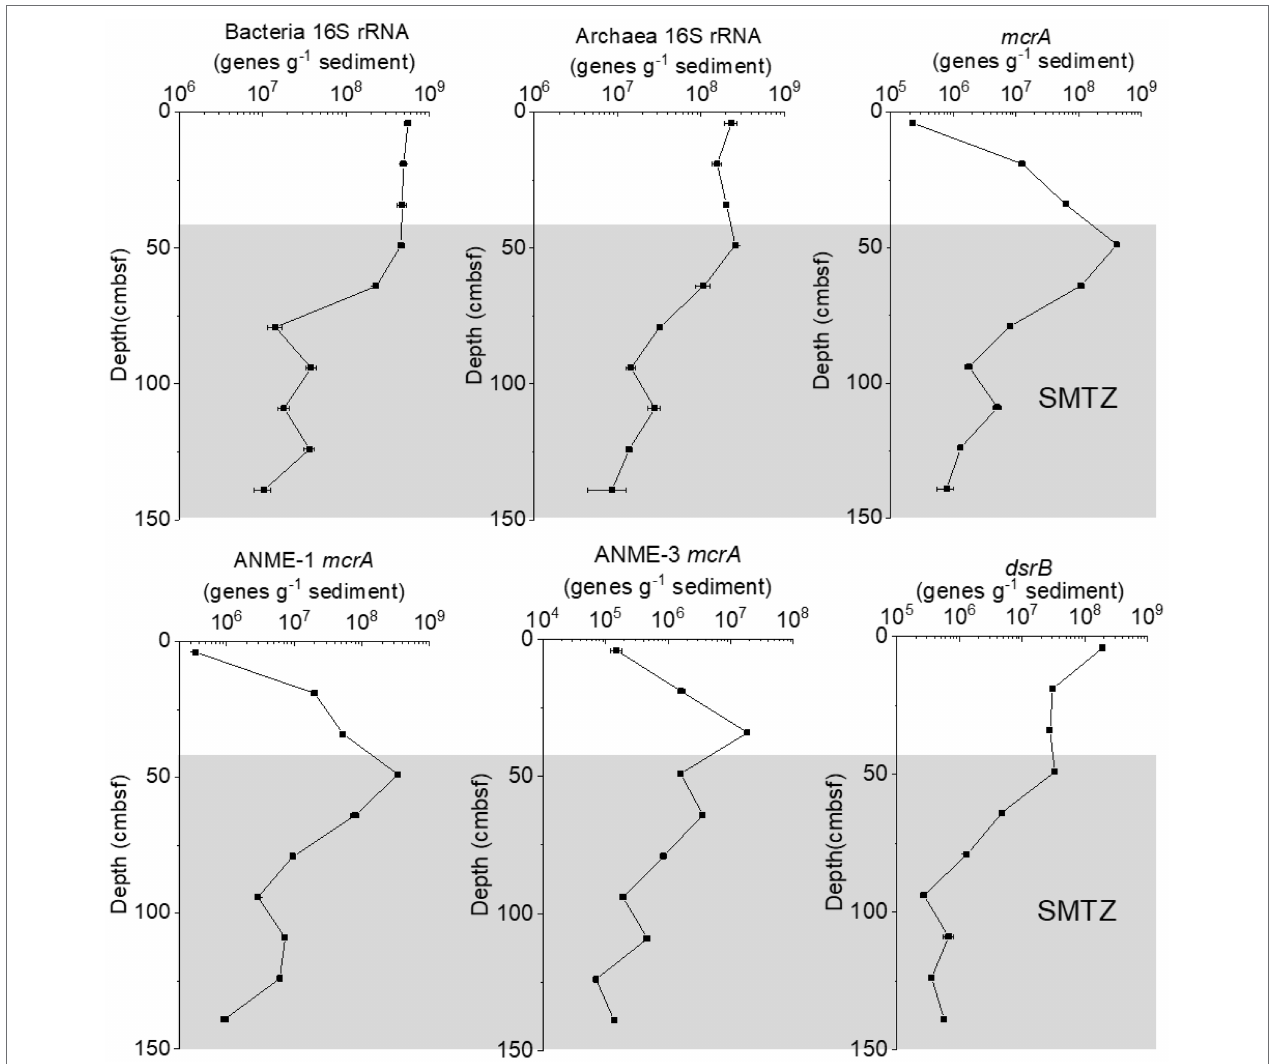
FIGURE 3 | Gene abundance of the bacterial 16S rRNA, archaeal 16S rRNA, mcrA , ANME-1 mcrA , ANME-3 mcrA , and dsrA genes in the GC2020-02